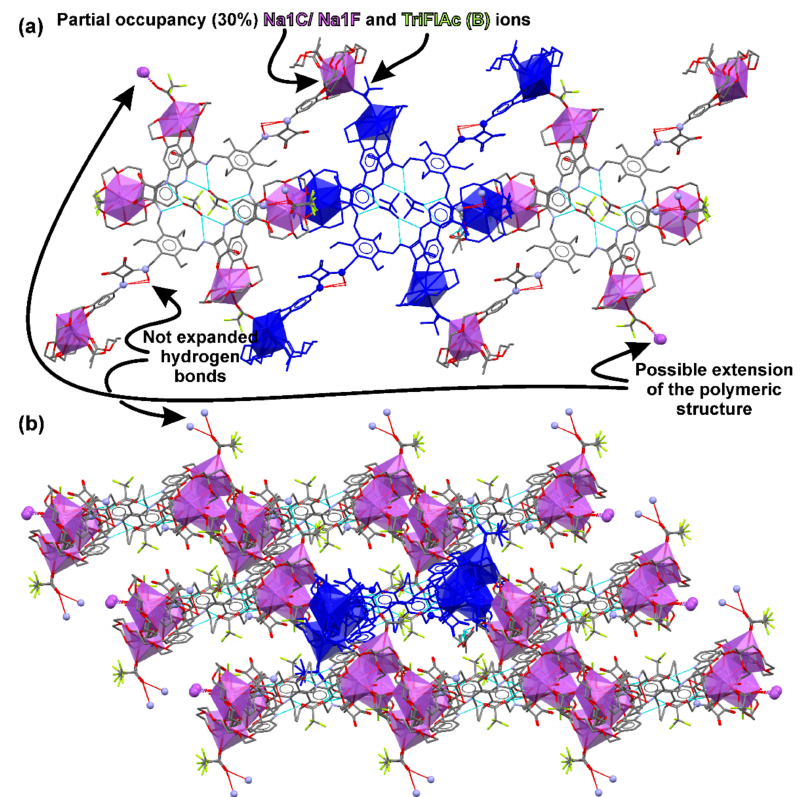
Figure 6. Polymeric structure formation in crystals of 1 + Na_triFlAc ( a ) and its extension to two-dimensional (2D) layers thanks to hydrogen bond ( b ). The atoms colored in blue correspond to the centrosymmetric dimer presented in Figure 5. Violet polyhedra represent the coordination of Na + cations by crown ether rings. Hydrogen bonds with displayed complete moieties marked as cyan dashed lines, not expanded hydrogen bonds represented as red dashed lines. Unbound solvent molecules and H atoms omitted for clarity. The presented model assumes 100% presence of TriFlAc (B) anion. In the real case of a non-stoichiometric crystal, the polymeric structure would probably not have been formed due to presence of 70% acetonitrile at mixed site TriFlAc (B) / CH 3